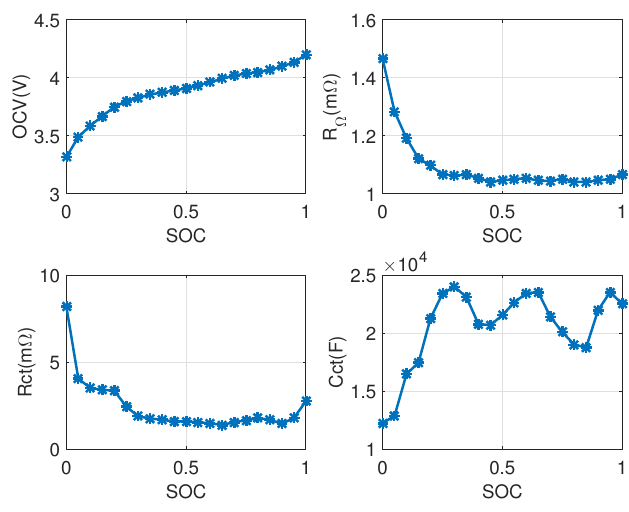
Figure 5. Estimation results of the first-order RC model parameters at 25 °C.